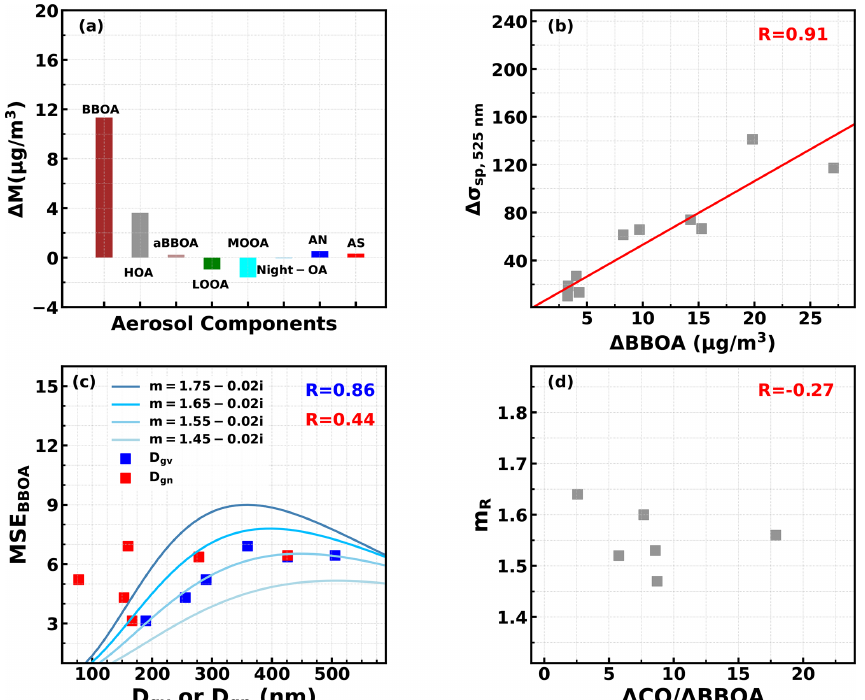
Figure 4. (a) Average differences of aerosol components between nearest background and the peak of BBOA spikes. (b) Relationships between derived (cid:49)σ sp at 525nm only associated with BBOA and (cid:49) BBOA. (c) Relationships between retrieved MSE BBOA and D gn or D gv . (d) Relationship between retrieved m R and (cid:49) CO /(cid:49) BBOA.